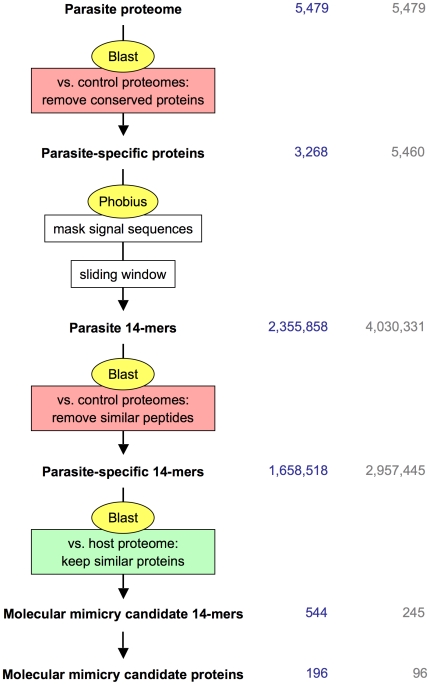
The in silico pipeline for identification of molecular mimicry candidates from parasites.See Methods for details. The process is illustrated with the actual numbers from the analysis of the P. falciparum proteome in blue, respectively a randomized version of it in grey, vs. the host H. sapiens.